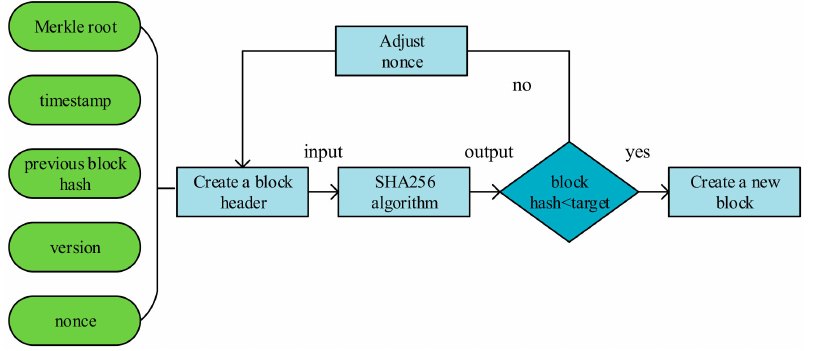
Figure 7. The working principle of the PoW